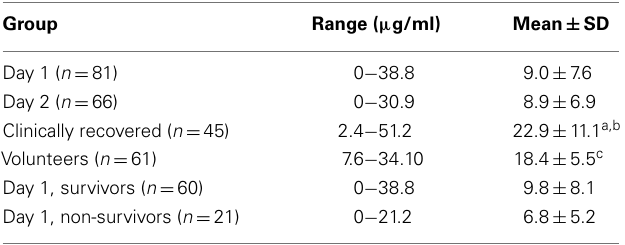
Table 1 | Properdin levels in sera of critically ill patients with sepsis admitted to ICU and a healthy control group .